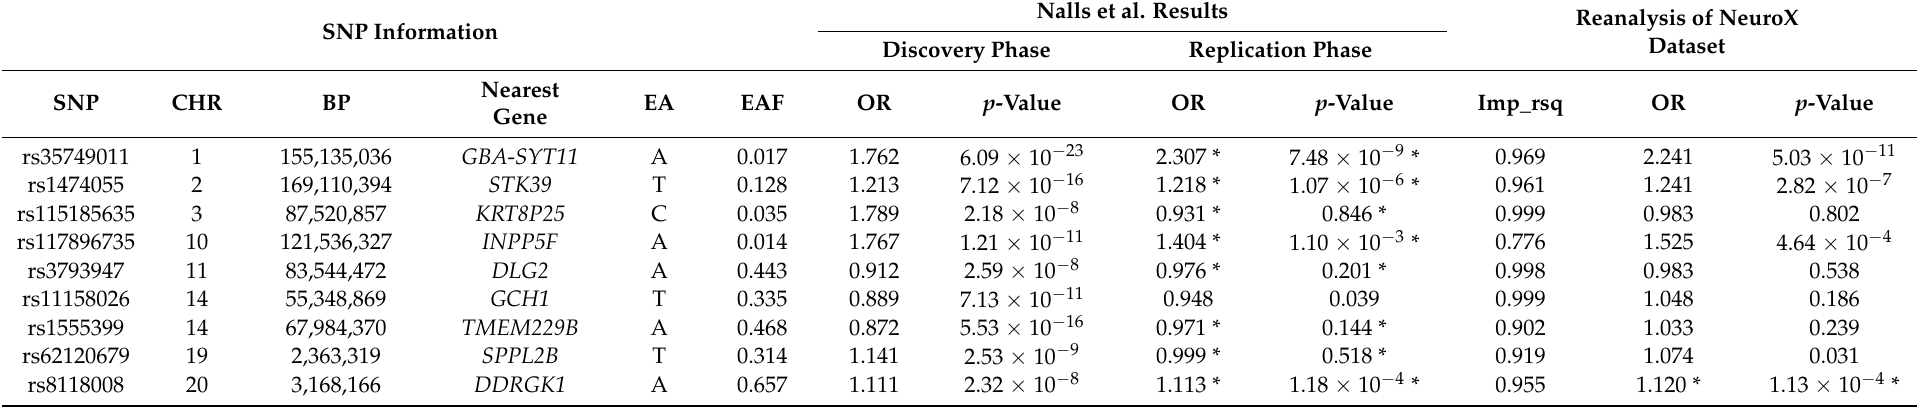
Table 4. Comparison of association results with Nalls et al. for SNPs not available in NeuroX dataset. SNP